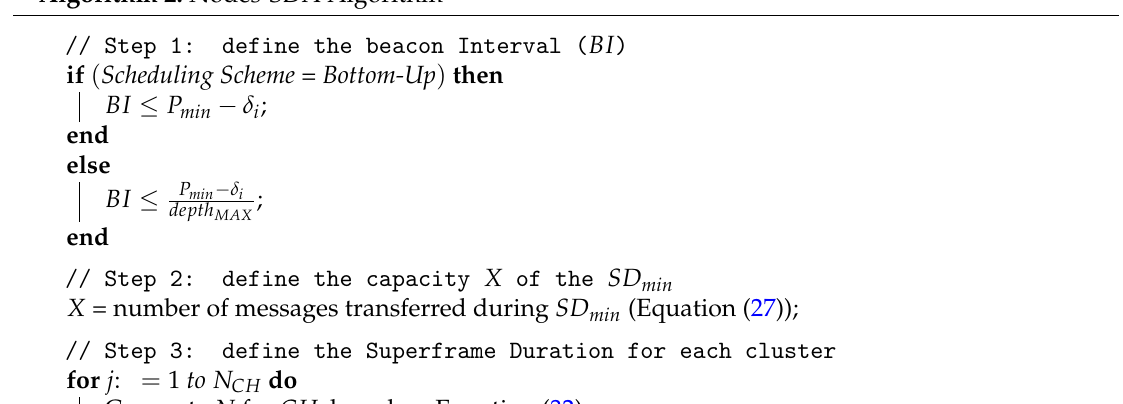
Algorithm 2: Nodes-SDA